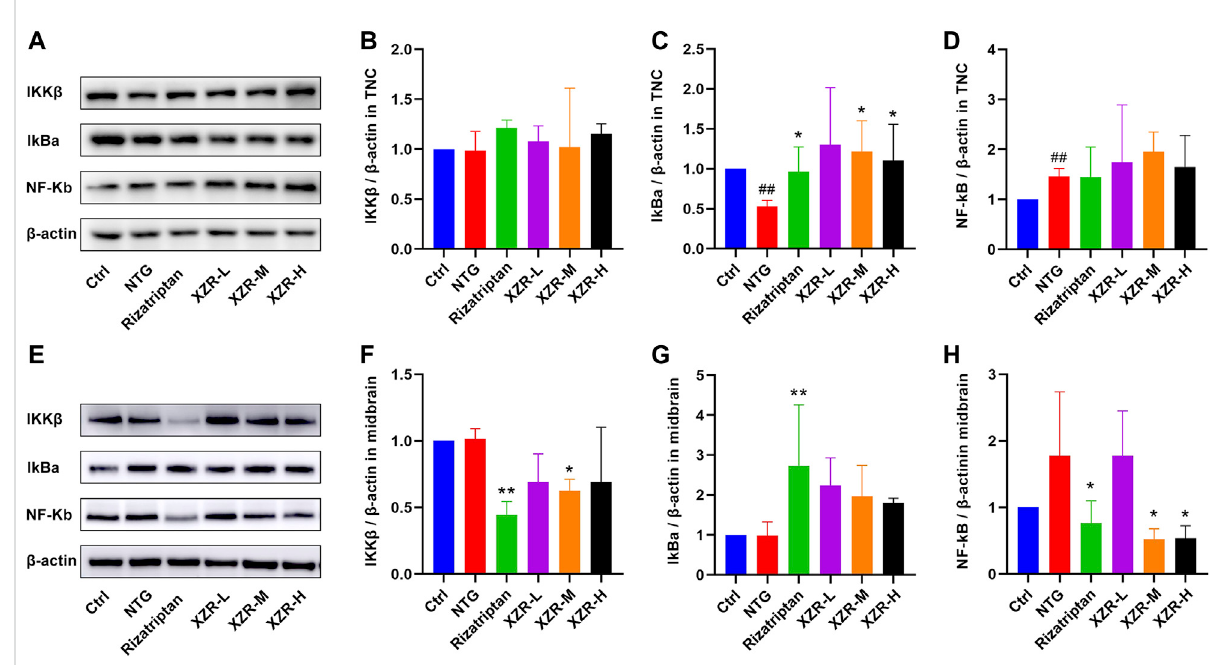
XZR inhibited in fl ammation via the NF- κ B signaling pathway. (A) Representative Western blot images of IKK β , I κ B α , and NF- κ B expression in the TNC. (B) Relative expression of IKK β in the TNC. (C) Relative expression of I κ B α in the TNC. (D) Relative expression of NF- κ B in the TNC. (E) Representative Western blot images of IKK β , I κ B α , and NF- κ B expression in the midbrain. (F) Relative expression of IKK β in the midbrain. (G) Relative expression of I κ B α in the midbrain. (H) Relative expression of NF- κ B in the midbrain. Data are presented as the mean ± standard deviation, n = 3 – 5. ## p < 0.01 versus the control group, * p < 0.05, ** p < 0.01 versus the NTG group. XZR, Xiongshao Zhitong Recipe; NTG,